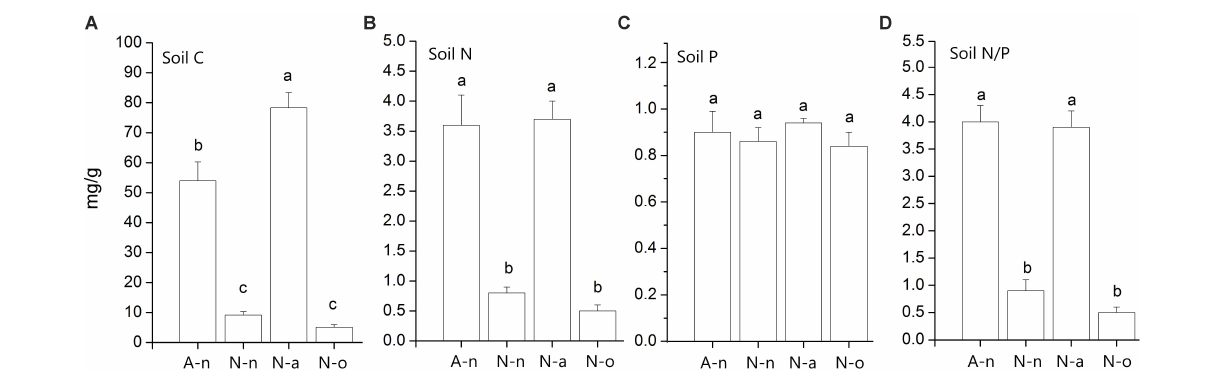
Frontiers in Ecology and Evolution |